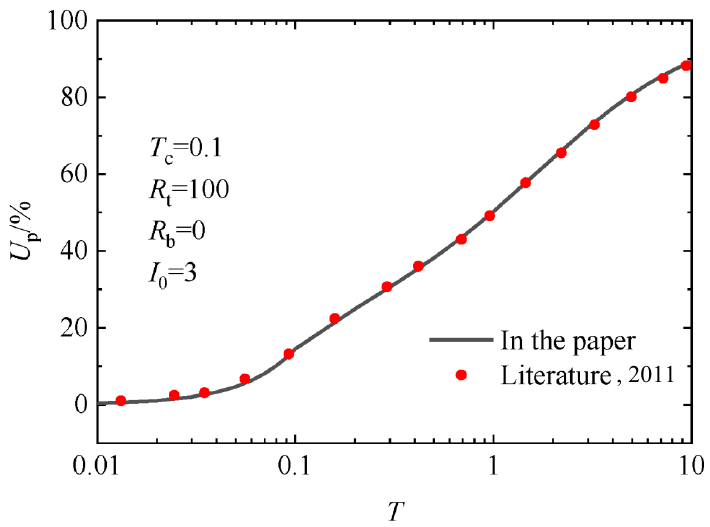
Figure 2. The verification of non-Darcian flow described by the non-Newtonian index [22].